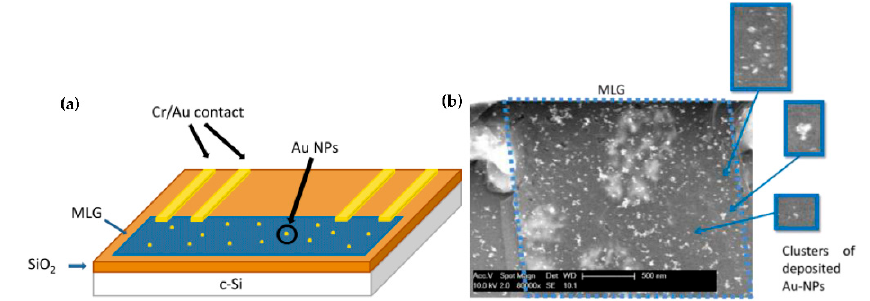
Figure 1. ( a ) Device schematic, on the multi-layered graphene (MLG) bar (206 μ m long, 10 μ m wide) where the gold nanoparticles are deposited. The Cr/Au contacts represent the pads of the resistor; ( b ) SEM image of a portion of the MLG-based device (enclosed in the dashed frame) after the Au-NPs’ deposition. The clusters of Au-NPs are shown in the blue frames.